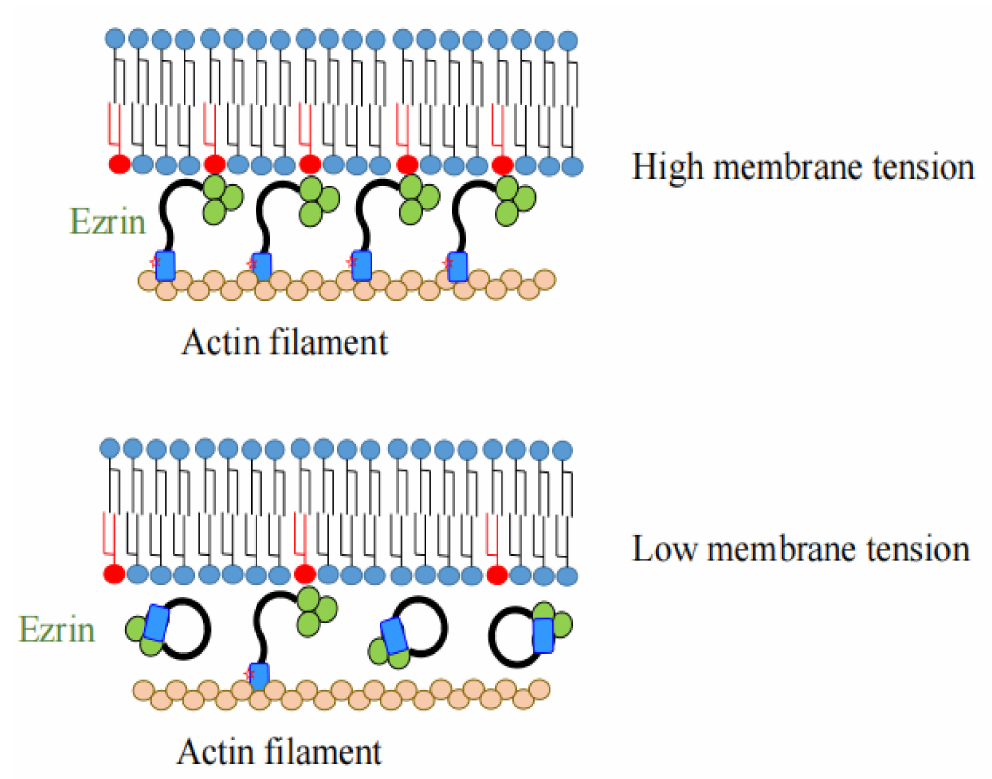
Figure 4. Ezrin functions as a regulator of plasma membrane tension. Plasma membrane tension is dominated by the attachment of actin filaments to the inner leaflet of the plasma membrane. Ezrin plays an important role by linking PtdIns(4,5)P 2 (shown in red) located in the inner leaflet of the plasma membrane and the actin cytoskeleton. The membrane tension is increased by the increased amounts of PtdIns(4,5)P 2 and by the activation of ezrin (shown in the upper part of figure). Conversely, it is decreased by the decreased amounts of PtdIns(4,5)P 2 and by the inactivation of ezrin (shown in the lower part of